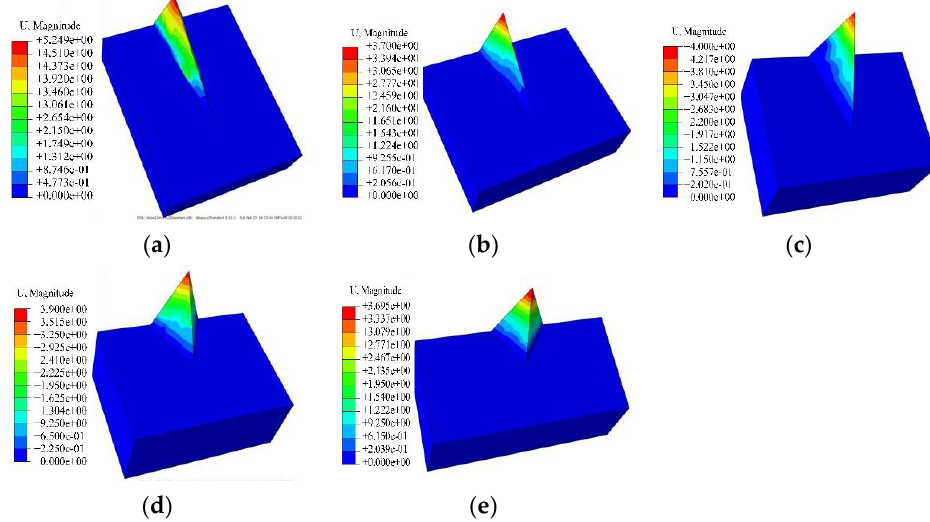
Figure 5. Displacement cloud map of ridge slope under different ridgeline dip angles (unit: m); ( a ) α = 20 ◦ ; ( b ) α = 30 ◦ ; ( c ) α = 40 ◦ ; ( d ) α = 50 ◦ ; ( e ) α = 60 ◦ .